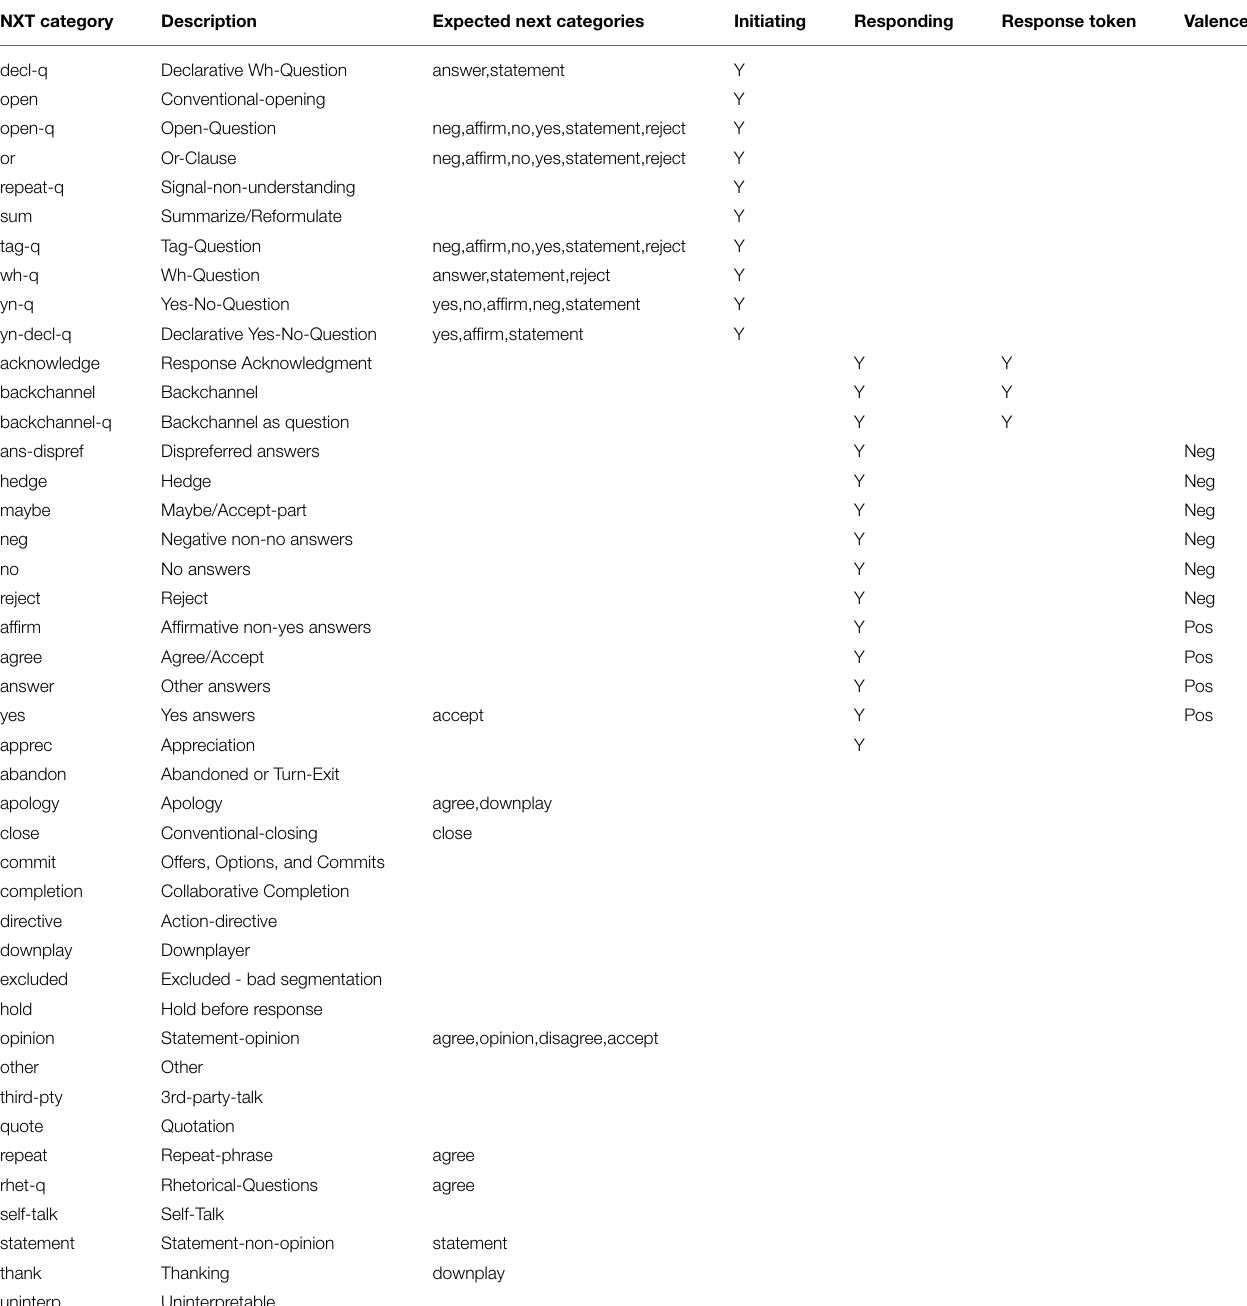
TABLE 1 | The NXT dialog act categories and how they map onto sequence organization types. NXT